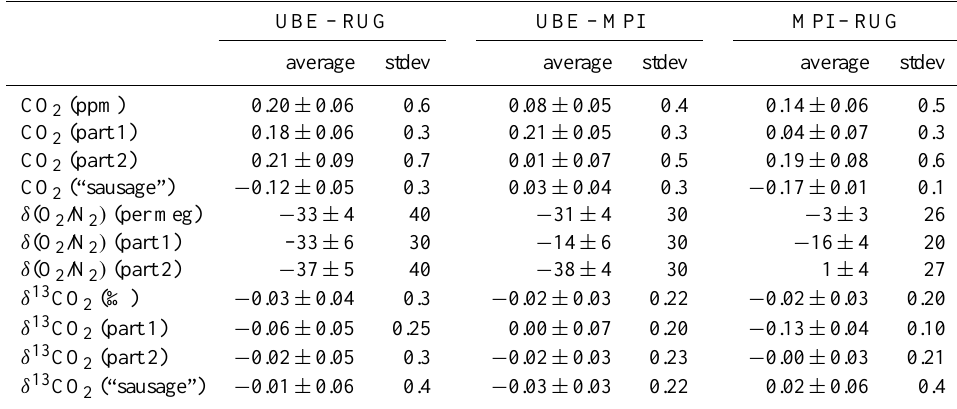
Table 2. Average CO 2 , δ (O 2 /N 2 ) and δ 13 CO 2 differences between each pair of two laboratories and their standard errors of the mean. Also given are the standard deviations. The results are given for the entire data set as well as for the two sub-periods: before March 2009 (part 1) and after March 2009 (part 2). The results from the “sausage” program are also included.